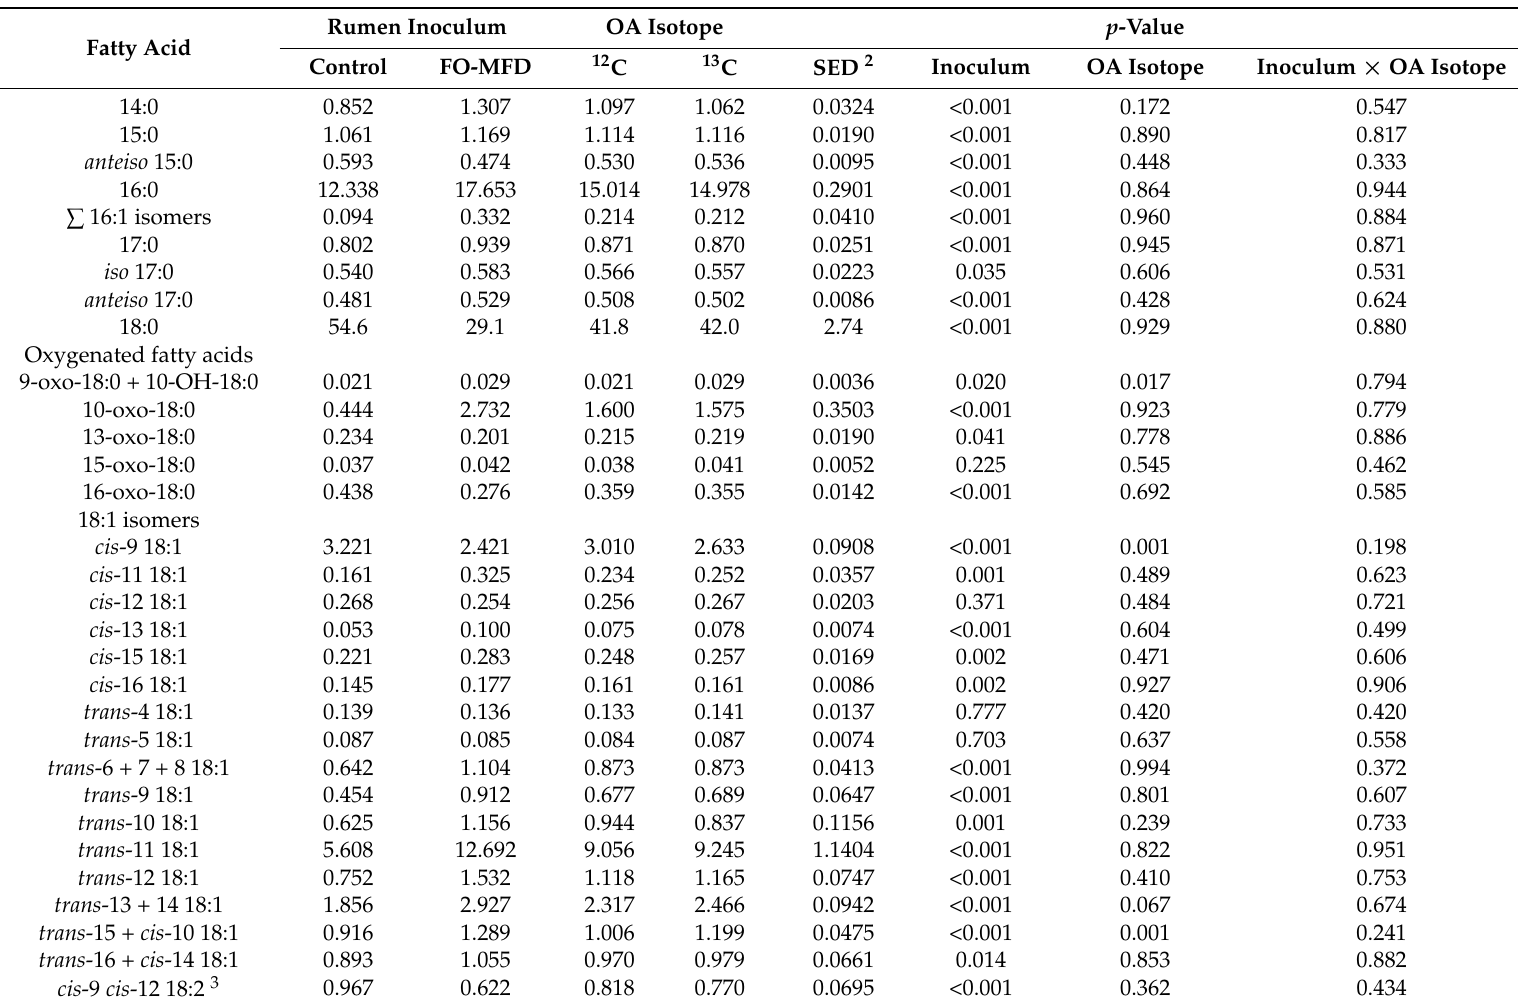
Table 1. Effects of rumen inoculum (control vs. FO-MFD 1 ) and oleic acid (OA) isotope ( 12 C vs. 13 C) on the fatty acid profile of digesta (expressed as % of total fatty acids) after 24 h of in vitro